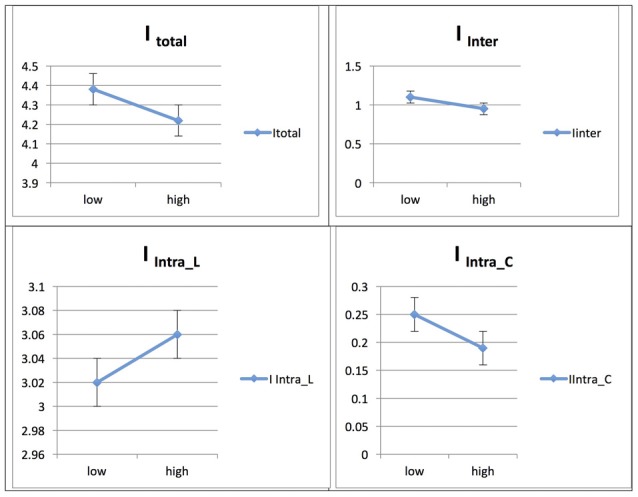
Probability value of the network integration differences across phases for L1 (Persian) in the Persian-speaking group. I = integration, ITotal = total integration value, IIntra_Language = Intra-integration of language areas, IIntra_Control = Intra-integration of cognitive control areas and IInter = integration between the two networks (language processing and cognitive control). A probability greater than 0.9 is considered significant.